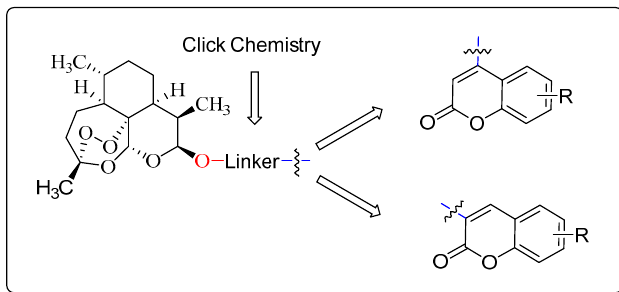
Figure 1. Structures of new designed Dihydroartemisinin–Coumarin hybrids.